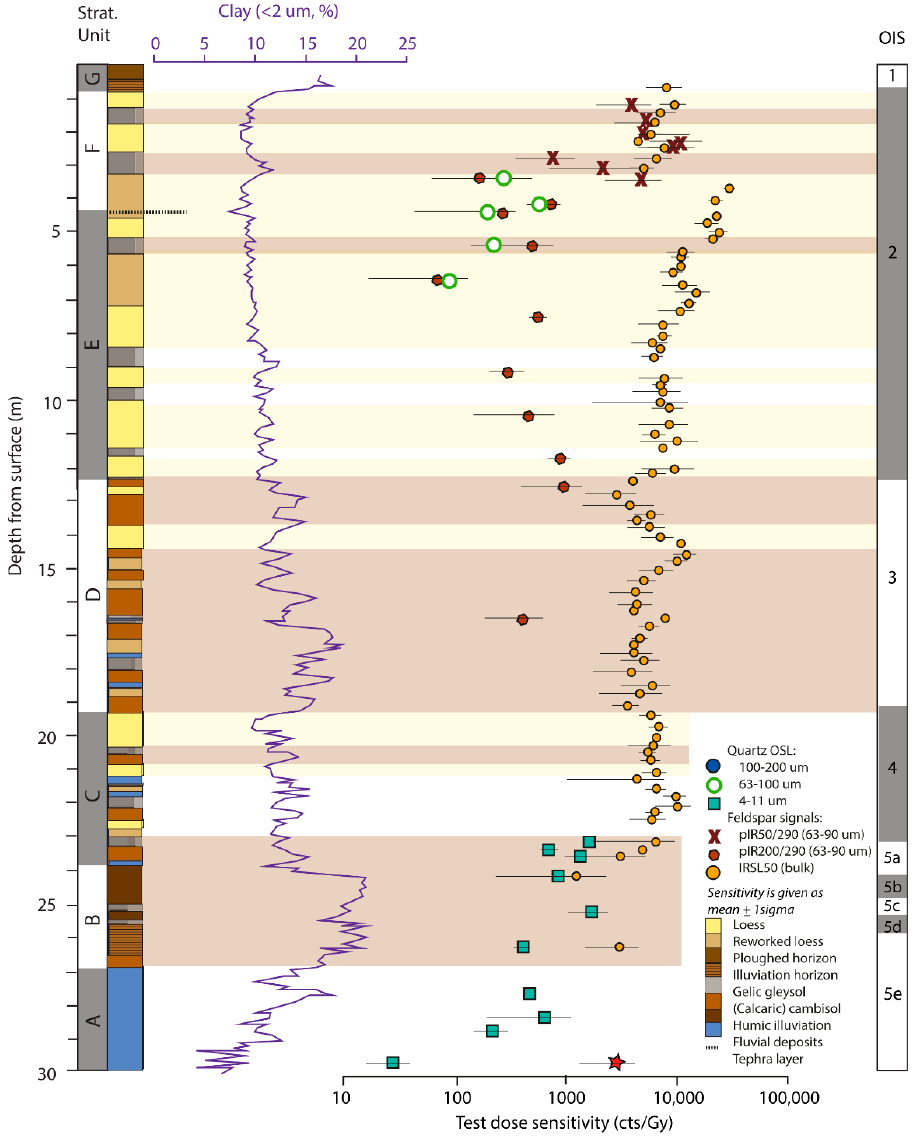
Figure 4. Comparison of luminescence sensitivity (median ± 1 σ ) with depth down the REM3B core, for quartz OSL, feldspar pIR 290 and bulk IR 50 signals, plotted against simplified stratigraphy, stratigraphic units and clay percentages from [53]. Major primary loess units are highlighted in yellow and palaeosol horizons in brown.